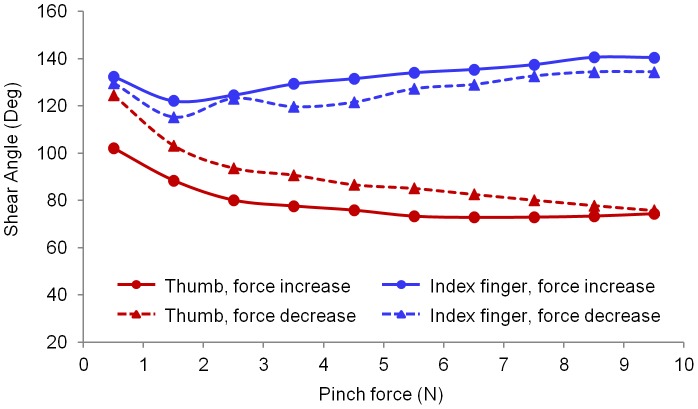
Projection angle for the thumb and index finger.Each data point represents the average of SA for all the trials within the specified 1-N force interval.